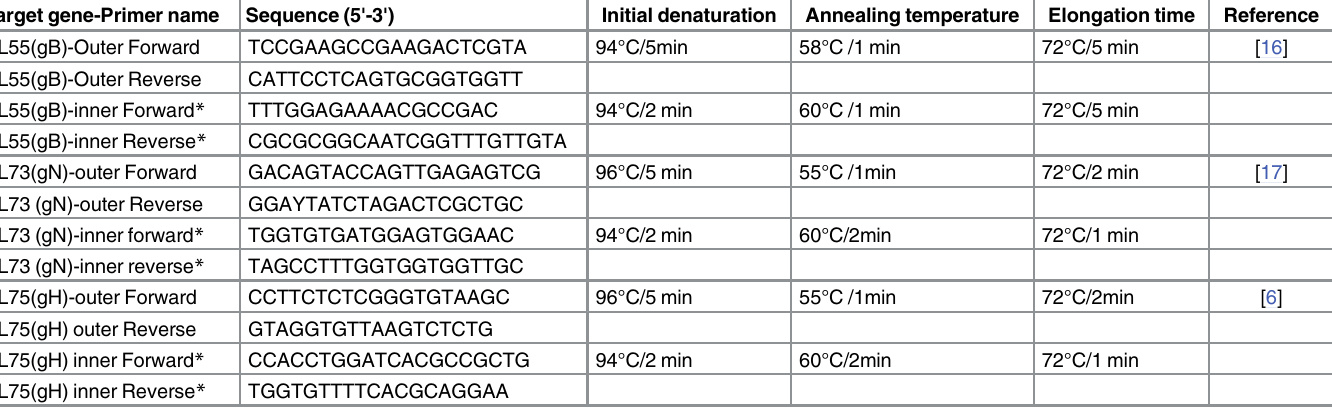
Table 1. Oligonucleotide primers and thermal conditions used for PCR and sequencing of cytomegalovirus. Target gene-Primer